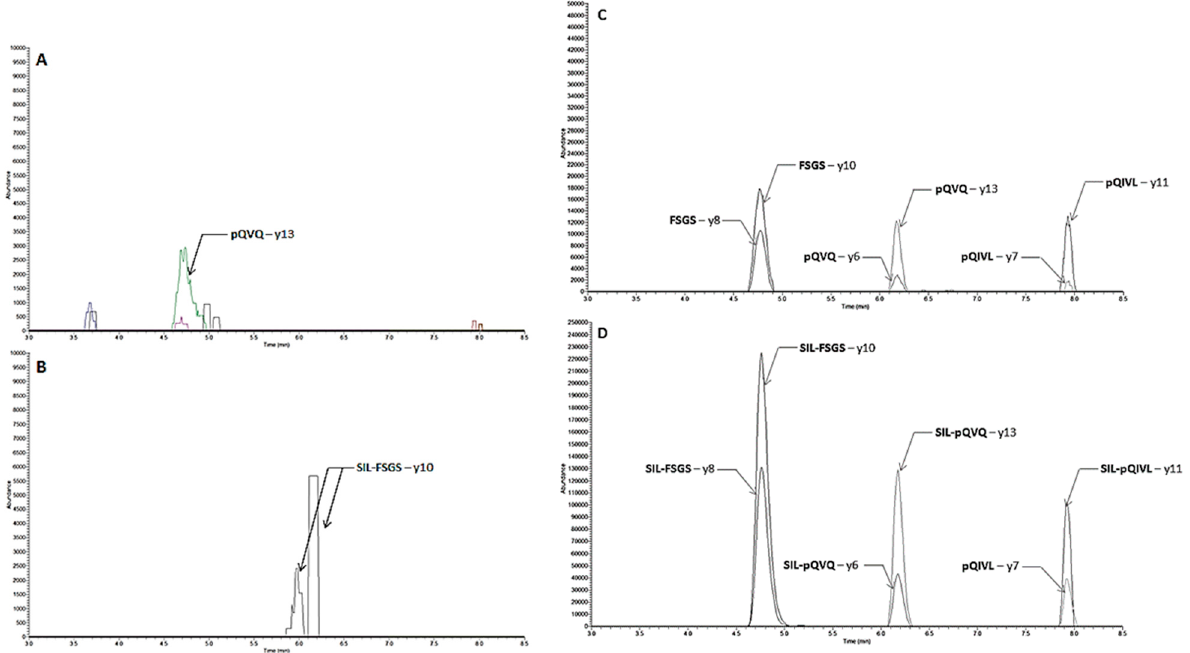
Figure 4. PRM chromatograms with LC-MS/HRMS assay of rituximab ( A ) and ( C ) and SIL-rituximab ( B ) and ( D ). A and B : blank sample; C : sample spiked at 2 µ g/mL (lower limit of quantitation (LLOQ)); D : SIL-rituximab at 15 µ g/mL.